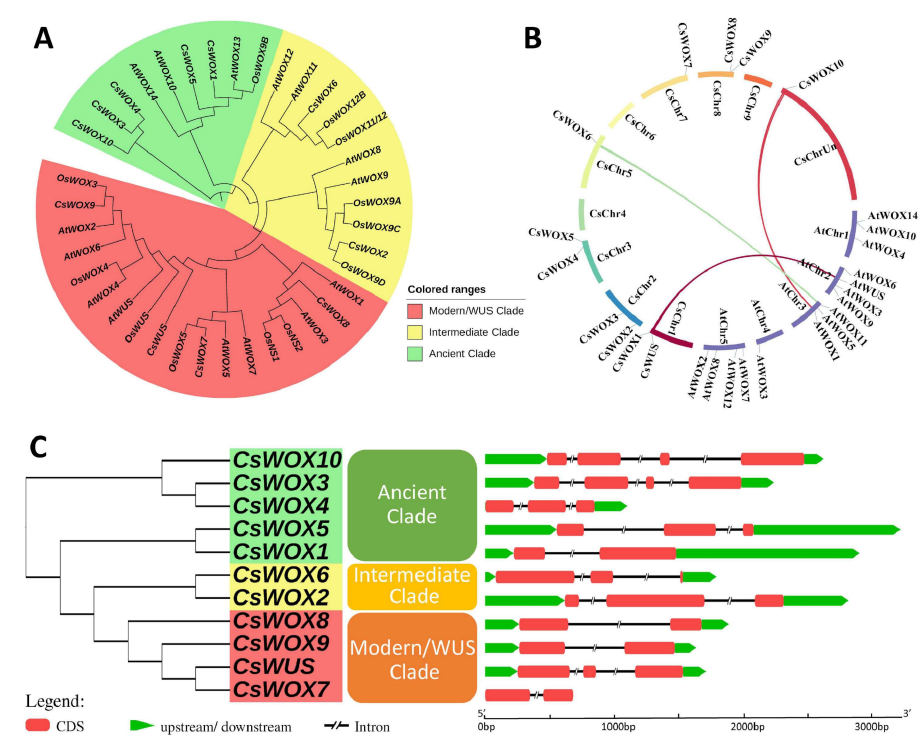
Figure 1. Phylogenetic tree, synteny analysis, exon, and intron distribution of WOX genes of citrus. ( A ) Phylogenetic tree of citrus CsWOX; rice ( OsWUS : AM234746; OsWOX3 : AM234749; OsWOX4 : AM234750; OsWOX5 : AM234751: OsWOX9A : Q0JKK6; OsWOX9B : AM234755; OsWOX9C : AM234752; OsWOX9D : AM234753; OsWOX11/12 : AM234754 ; OsWOX12B : ABF95709; OsNS2 : AM234748; OsNS1 : AB218893); and Arabidopsis ( AtWUS : AT2G17950; AtWOX1 : AT3G18010; AtWOX2 : AT5G59340; AtWOX3 : AT2G28610; AtWOX4 AT1G46480; AtWOX5 : AT3G11260; AtWOX6: AT2G01500; AtWOX7: AT5G05770; AtWOX8: AT5G45980; AtWOX9: AT2G33880; AtWOX10: AT1G20710; AtWOX11 : AT3G03660; AtWOX12 : AT5G17810; AtWOX13 : AT4G35550; AtWOX14 : AT1G20700). ( B ) Synteny analysis and chromosomal distribution of CsWOX genes; colored bars joining two chromosomal regions represents syntenic regions. Chr, Chromosome. ( C ) Exon-intron distribution. CDS exon indicated by red boxes, upstream and downstream region indicated by green boxes, intron indicated by black